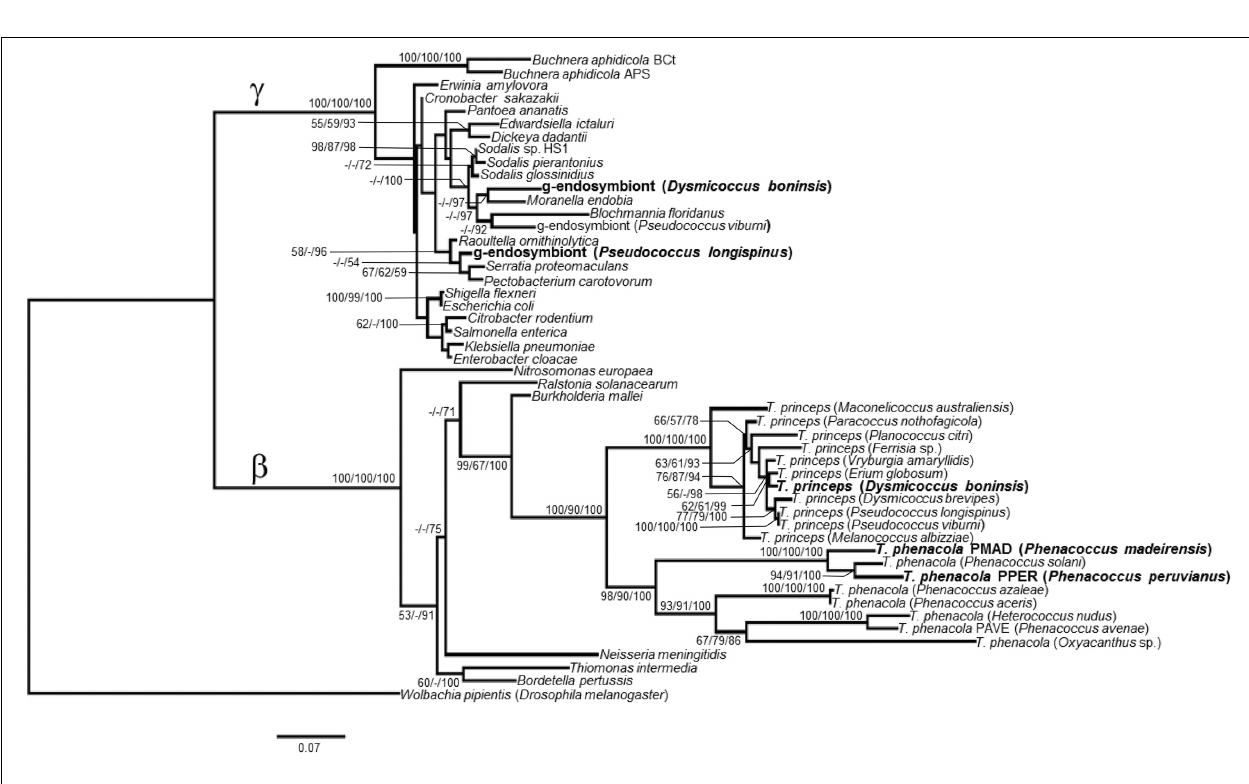
FIGURE 7 | ML phylogenetic analysis of gamma-endosymbionts and Tremblaya lineagesbasedontheir16SrDNAsequences. Wolbachiapipientis Dmel (alphaproteobacterial endosymbiont of Drosophila melanogaster ) was